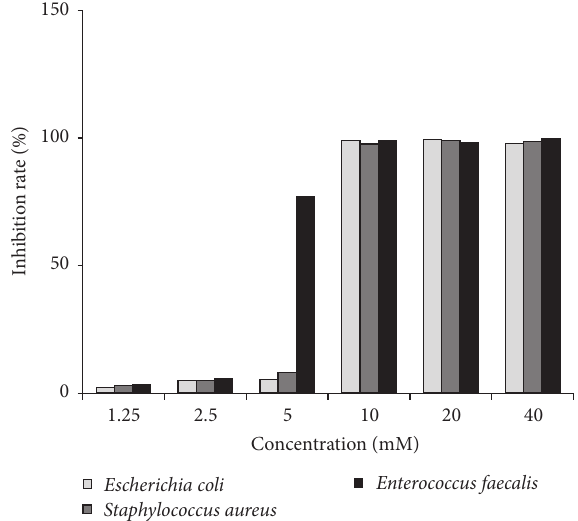
Figure 8: Effect of copper-amino acids chelate sample by MTT